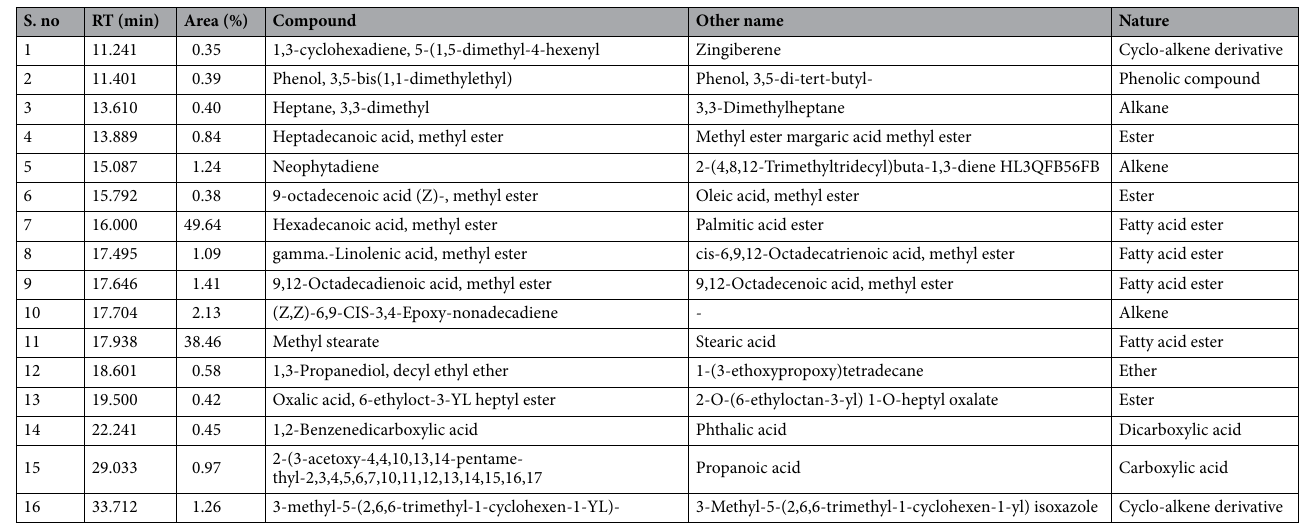
Table 1. List of compounds found by GC–MS of cyanobacterial